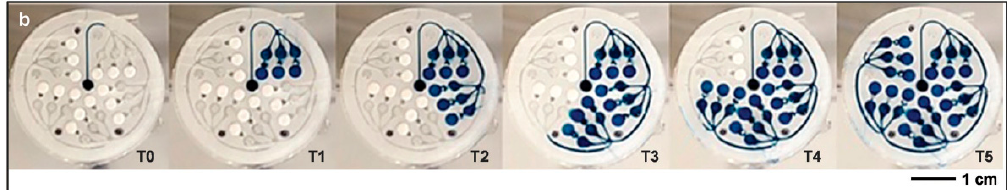
Figure 15. Pictures of the chrono-sampling of sweat (artificially colored in blue), introduced at a rate of 10 µ L min − 1 . The di ff erent areas are filled sequentially with the colored sweat solution depending on the swollen state of the superabsorbent polymer (SAP) valve. Reproduced from [56] with permission. © 2018 WILEY-VCH Verlag GmbH & Co. KGaA, Weinheim. However, electrochemical sensing protocols remain more quantitative than colorimetric